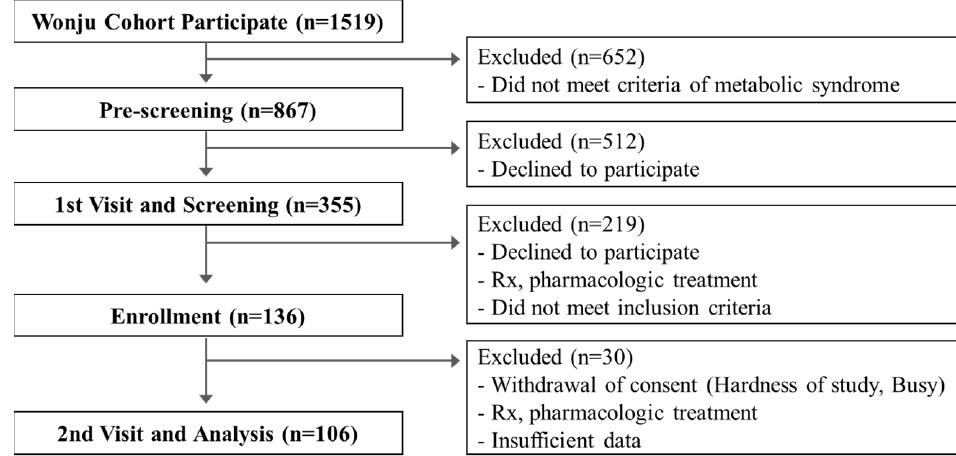
Figure 1. Flowchart of the study population selection.